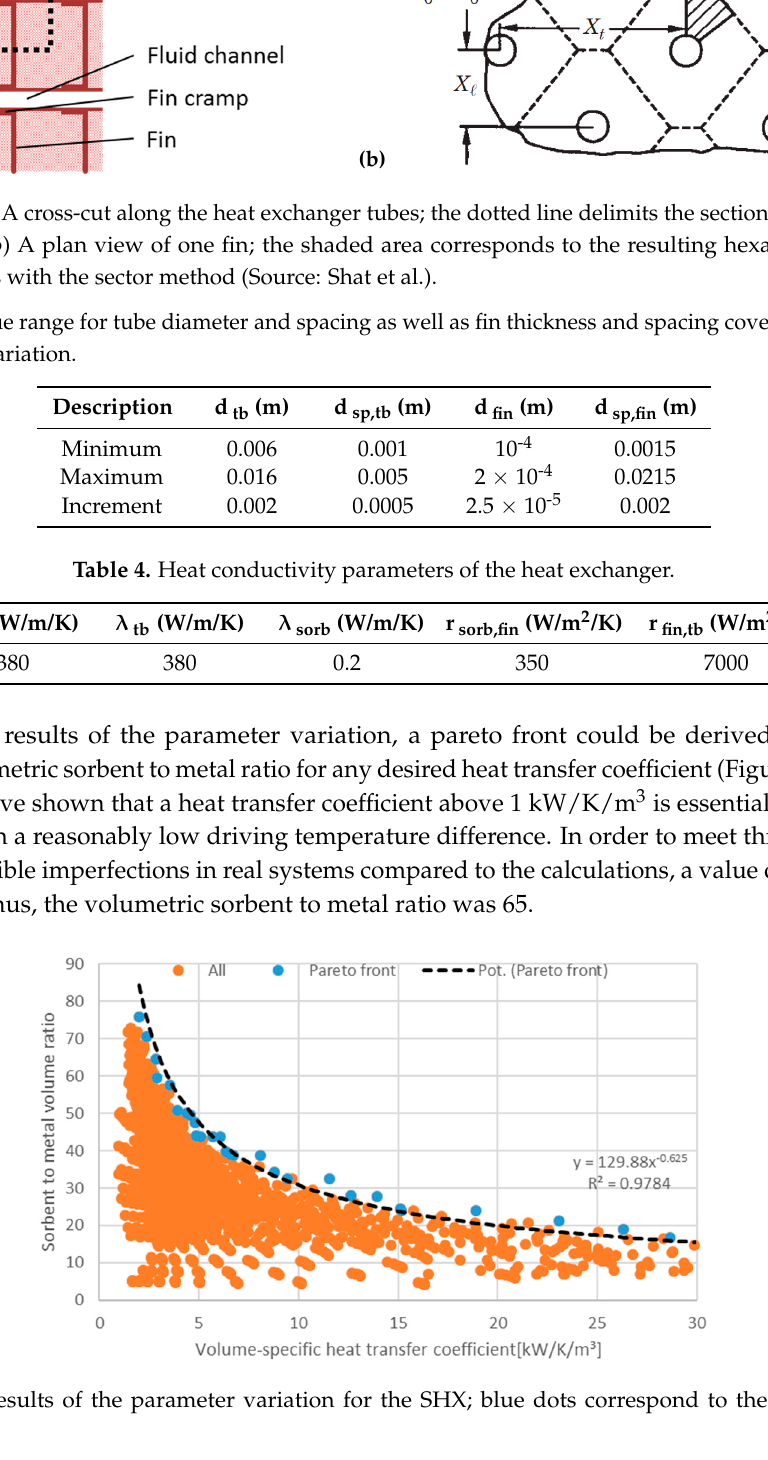
Figure 6. Results of the parameter variation for the SHX; blue dots correspond to the identified Pareto front.